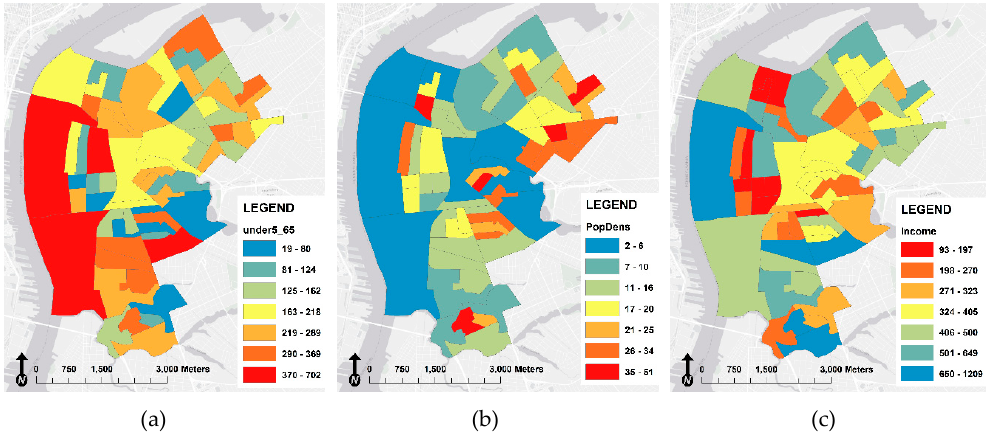
Figure 7. Social parameters mapped over Camden city: ( a ) population in age group of <5 and >65; ( b ) population density in block group; and ( c ) household income categorized within the census tracts of Camden.